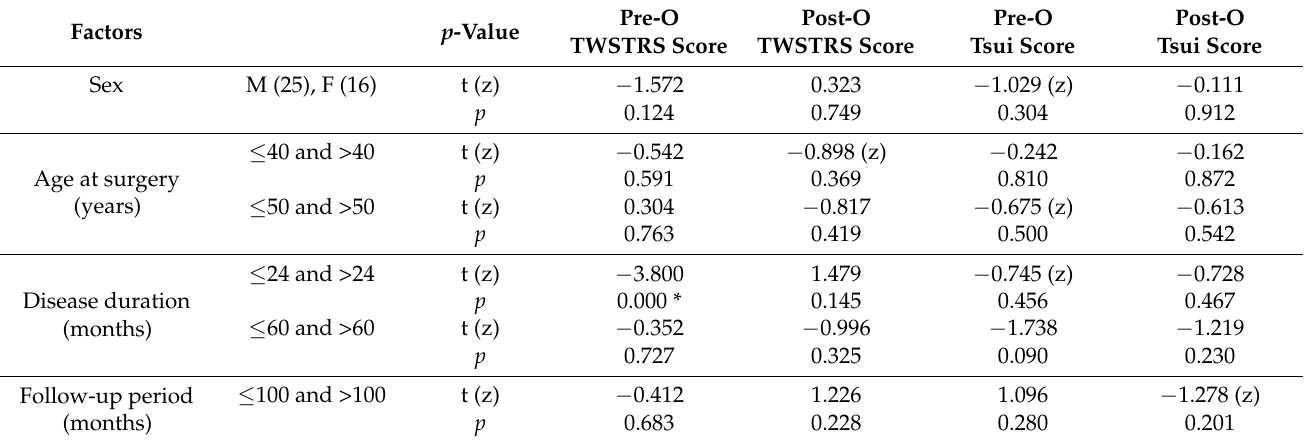
Table 4. Relative improvement in TWSTRS and Tsui scores at the last follow-up after DAM